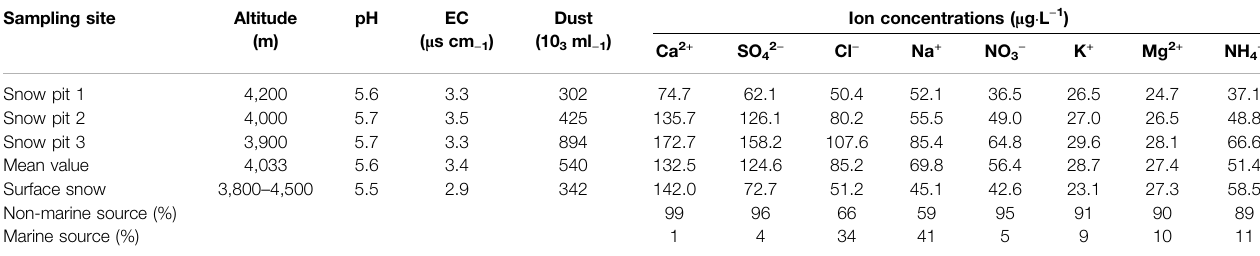
TABLE 1 | Properties of dust, pH, EC, and main ionic concentrations in snow pits and surface snow at Yushugou Glacier No. 6. Sampling site Altitude (m) Snow pit